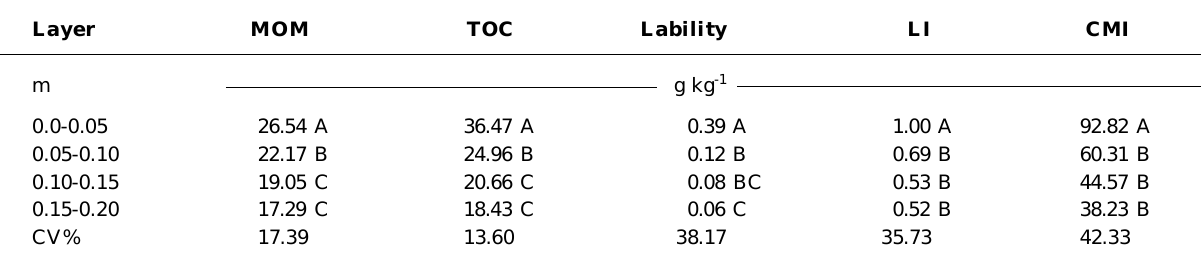
Means followed by the same capital letter in the column did not differ statistically from each other by the Tukey test at 5